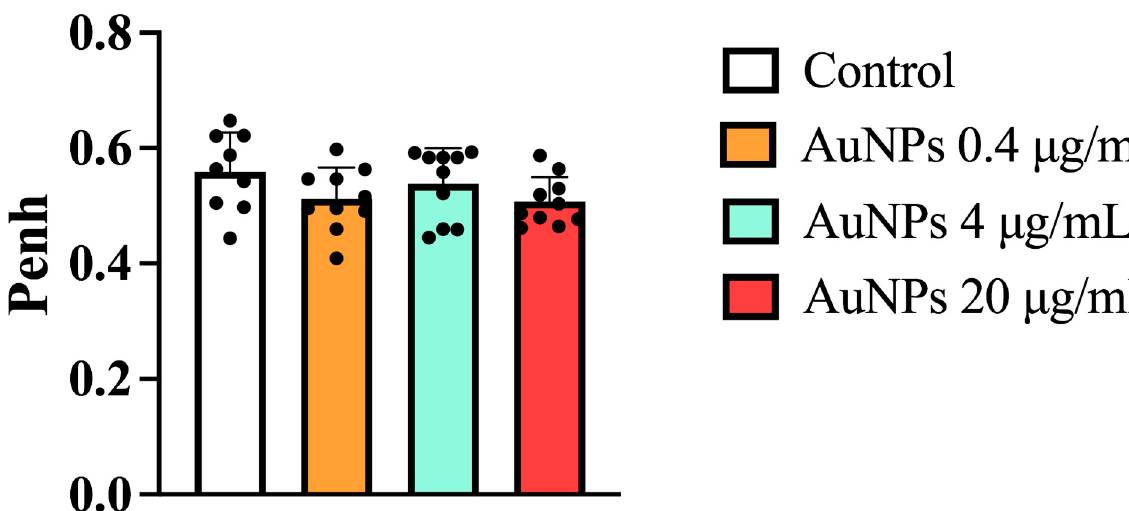
Figure A1. Effect of treatment with nebulized AuNPs on healthy A/J mice. Naïve A/J mice were subjected to AuNP nebulization (0.4; 4, and 20 μ g/mL) 3 times a week for 7 consecutive weeks. Airway resistance was measured using non-invasive plethysmography and expressed as Pause Enhancement (Penh). Data are expressed as mean ± SD of 10 mice for all groups except the saline group (n=9). Each dot represents an individual mouse.